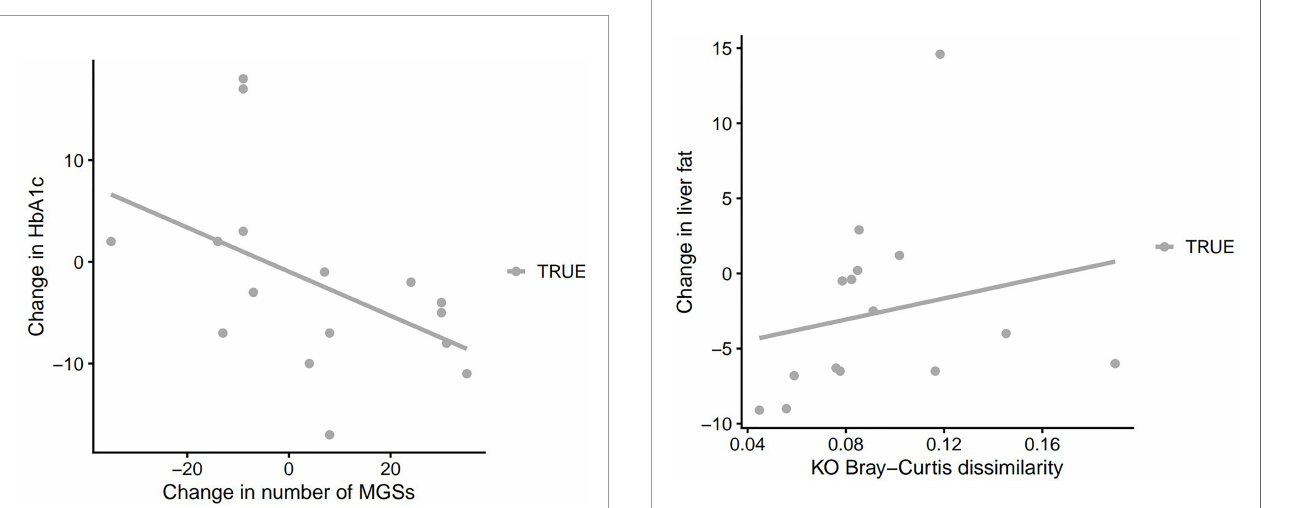
FIGURE 2 | Change in HbA1c as a function of change in MGS richness in the faecal samples at baseline and 3 months after DMR. HbA1c, haemoglobin A1c; MGS, metagenomic species; DMR, duodenal mucosal resurfacing.